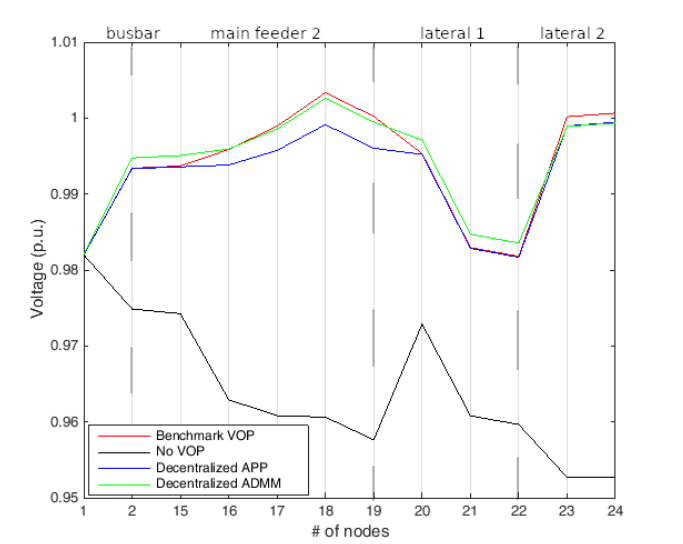
Figure 8. Voltage profiles along the main feeder 2 and the corresponding